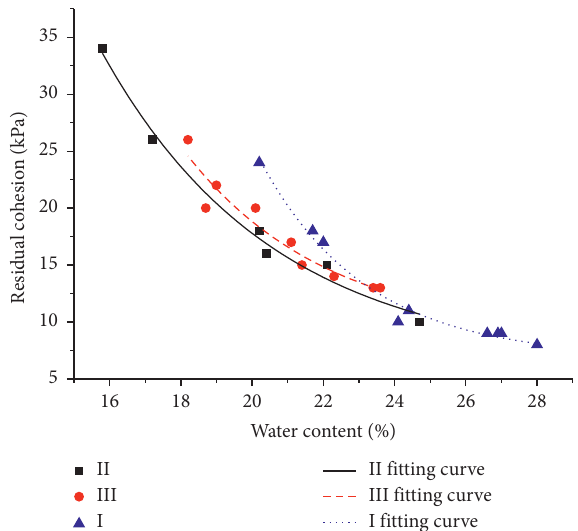
Figure 14: The curve of residual cohesive force with moisture content change.